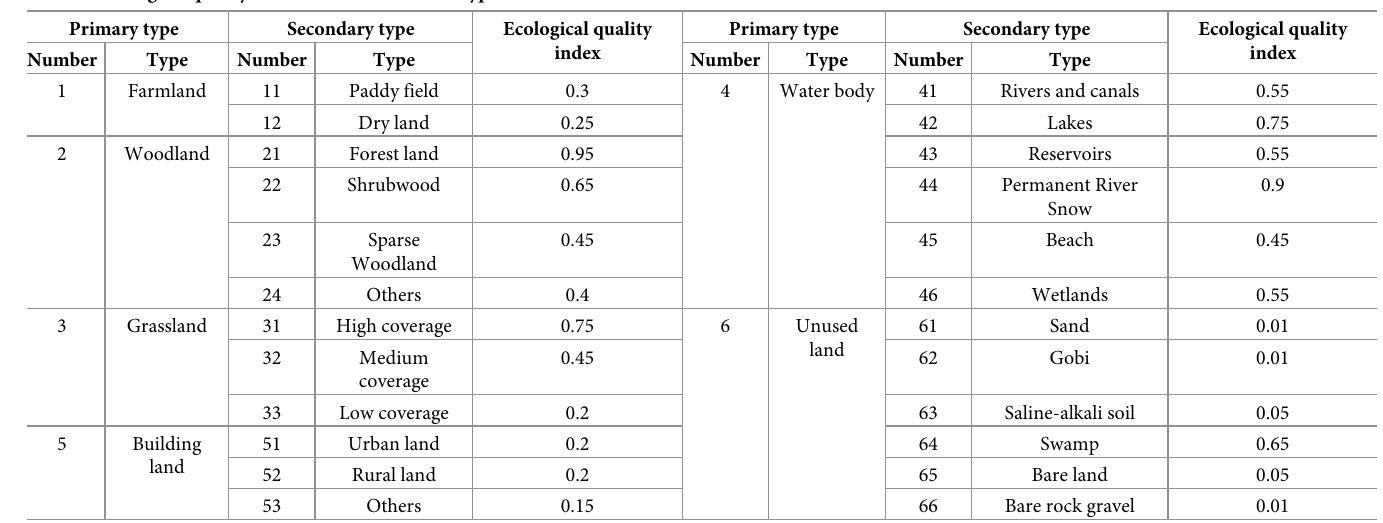
Table 3. Ecological quality index of various land use